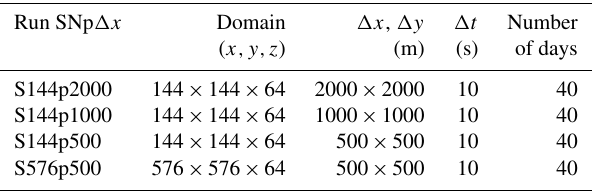
Table 2. Horizontal resolution of simulations with SAM. Np repre- sents the horizontal point